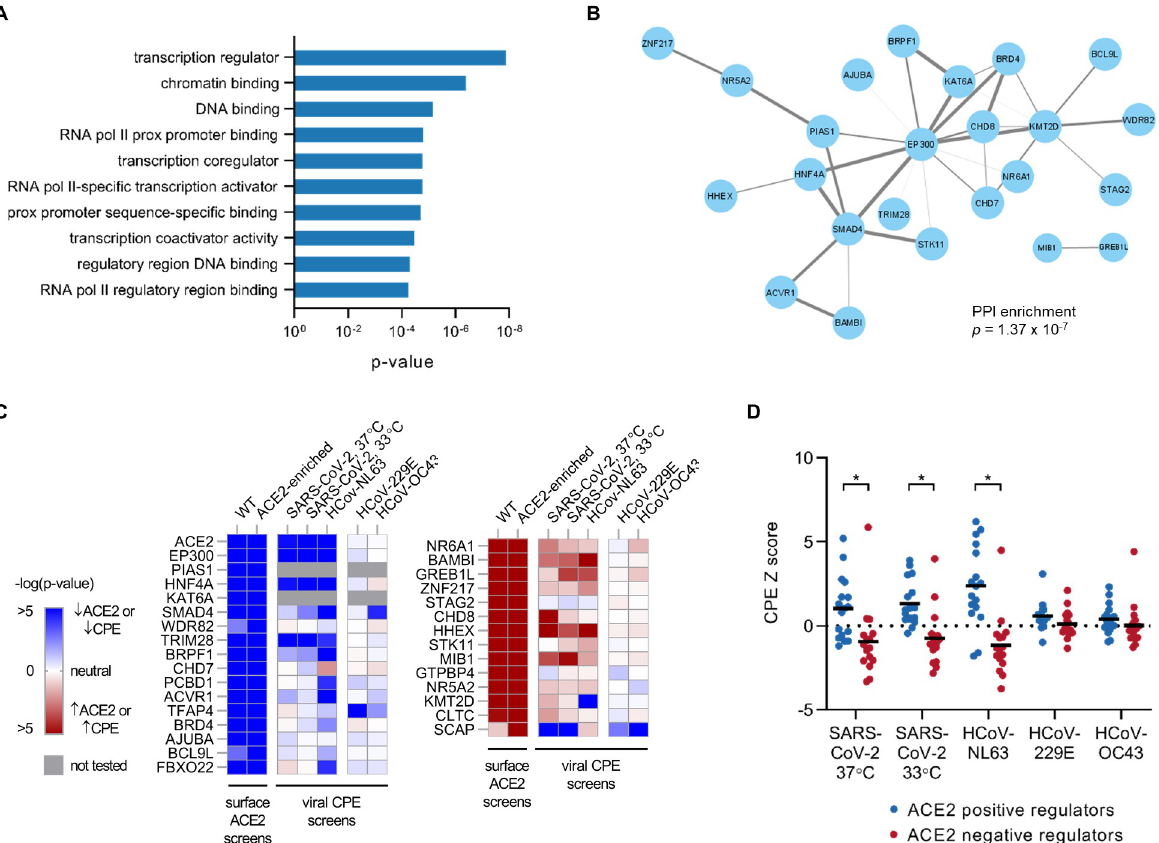
Fig 3. Analysis of ACE2 modifiers. (A) Top 10 molecular function ontologies enriched in genes identified as ACE2 modifiers relative to all genes tested in the focused CRISPR library. (B) Network analysis of ACE2 modifiers identified in the focused CRISPR screens of HuH7 WT or ACE2-enriched cells. Significance testing for the number of detected protein-protein interactions relative to a randomly selected gene set was calculated by STRING. Only nodes detected with a significant interaction with another node are displayed. The width of the edge between nodes is weighted by the strength of the protein-protein interaction by STRING. (C) Heat map of log-transformed p-values for each ACE2 modifier identified in this study in comparison to log-transformed p-values for cytopathic effect during infection of HuH7.5 cells with the indicated coronaviruses [35]. Viruses are grouped by those whose entry is mediated by ACE2 (SARS-CoV-2, HCoV-NL63) or by an alternative receptor (HCoV-229E, HCoV-OC43) (D) Comparison of CPE effect with the indicated coronavirus [35] for groups of genes identified in this study as ACE2 positive or negative regulators. Positive Z-scores correspond to gene disruption conferring resistance to CPE. Asterisks indicates p < 0.001 by Student’s t-test. A significant difference is observed for only those viruses whose cellular entry is ACE2-mediated.